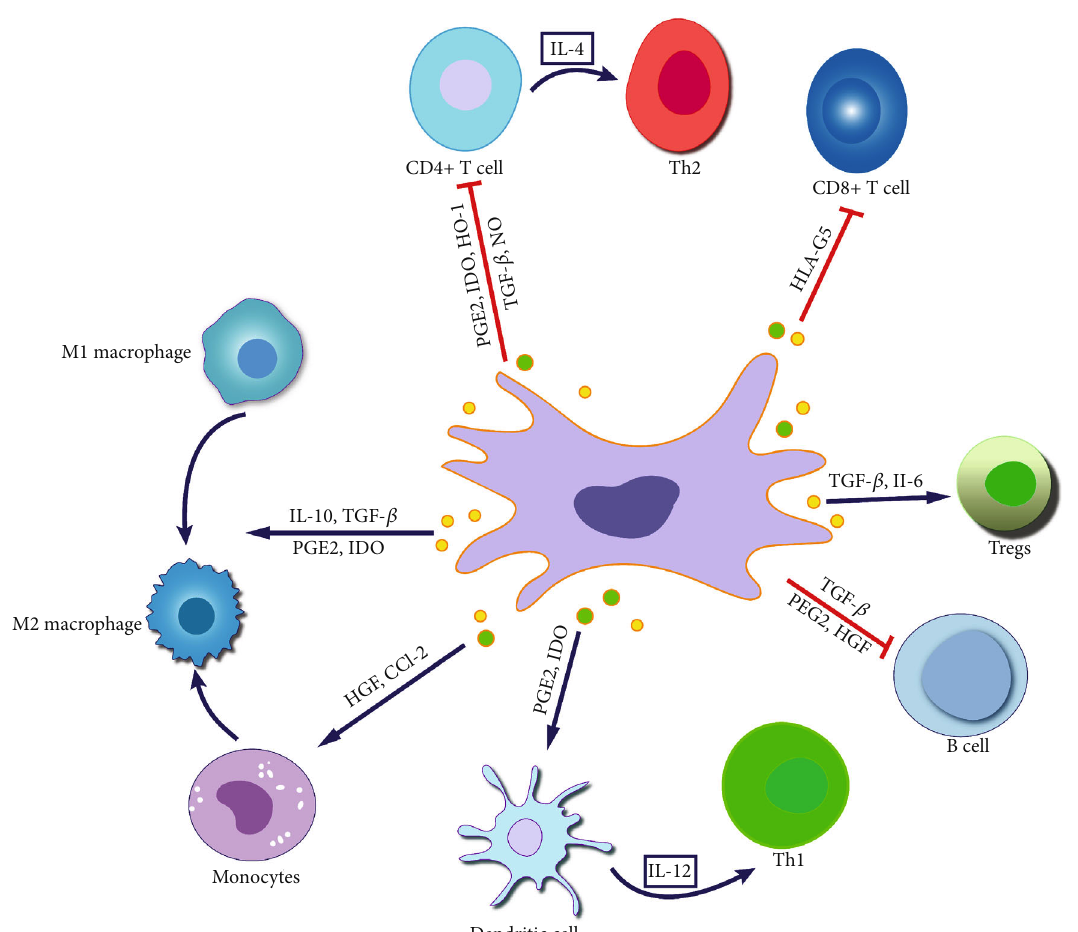
Figure 2: The e ff ects of MSC-EVs on immune e ff ector cells in